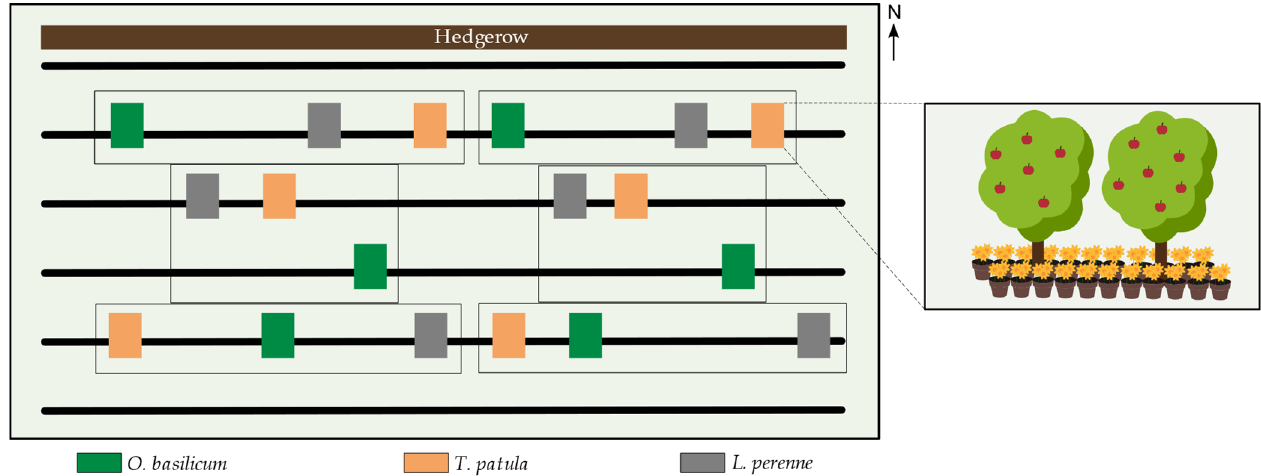
Figure 1. Experimental design: The two aromatic plant species Ocimum basilicum and Tagetes patula were intercropped with apple trees in an experimental apple orchard (six replicate plots per treatment in a randomized block design). Lolium perenne was used as negative control. Each plot comprised two apple trees framed by 50 companion plants arranged on both sides.